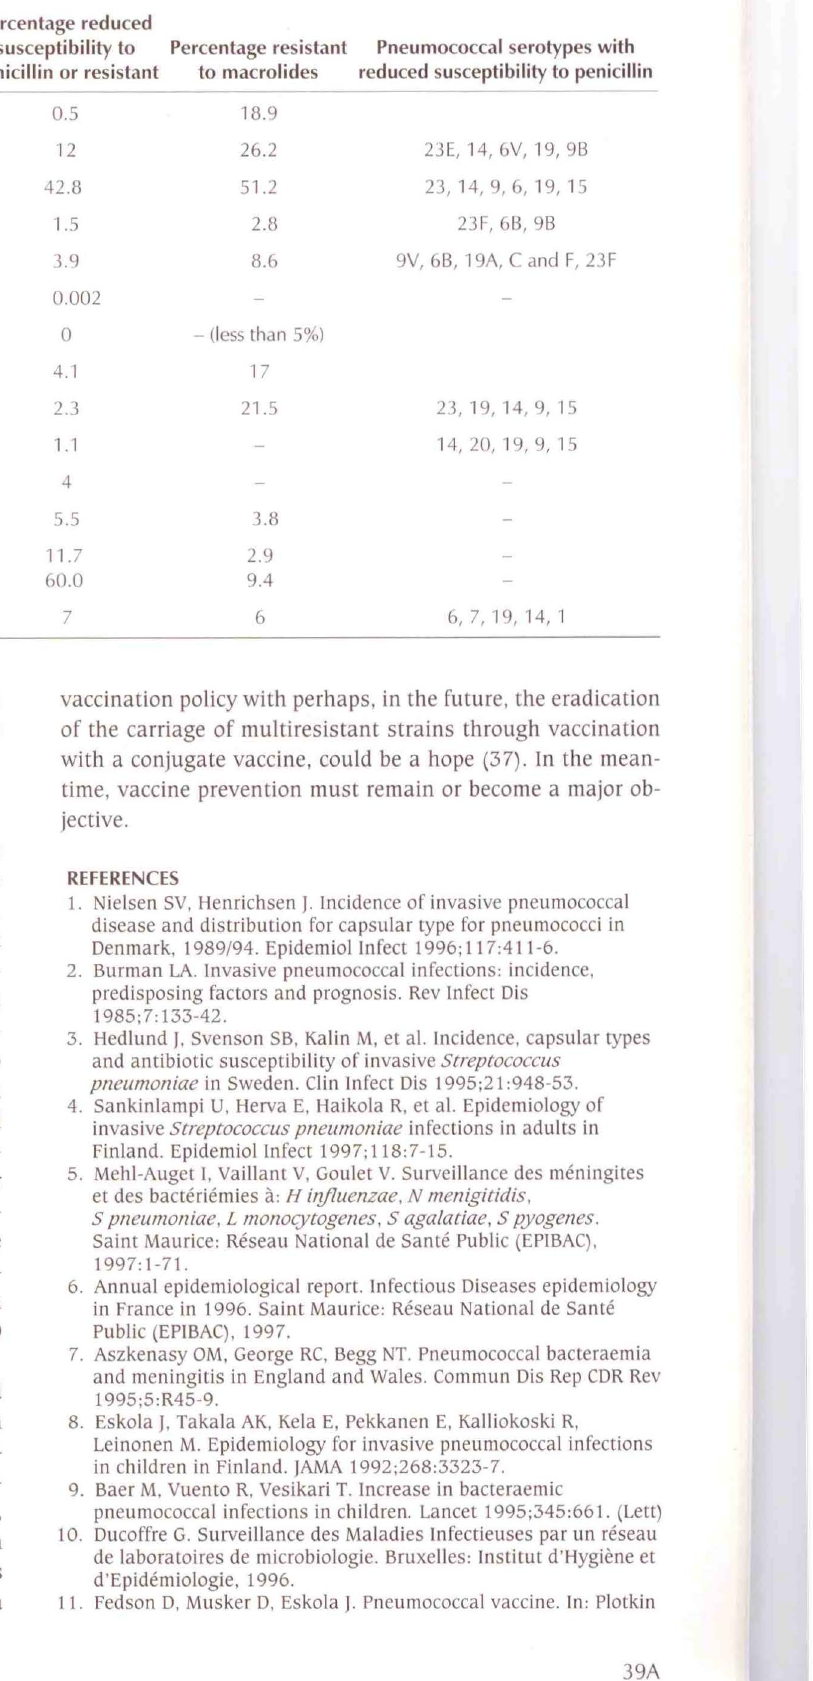
Global epidemiology of